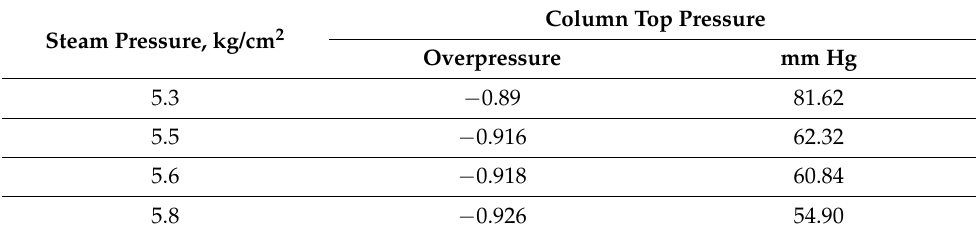
Table 10. Results of an industrial